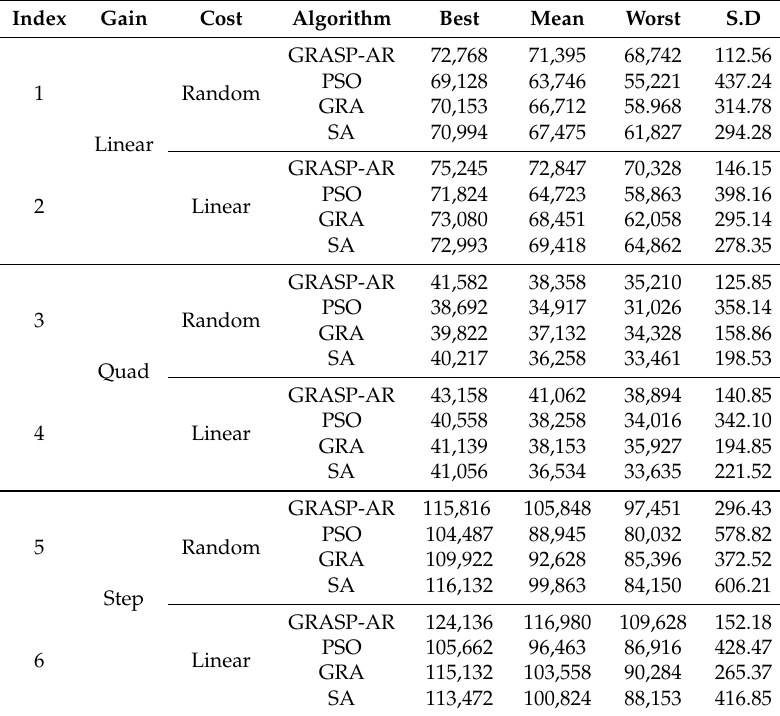
Table 6. Performance Comparison of GRASP-AR, PSO, GRA and SA.